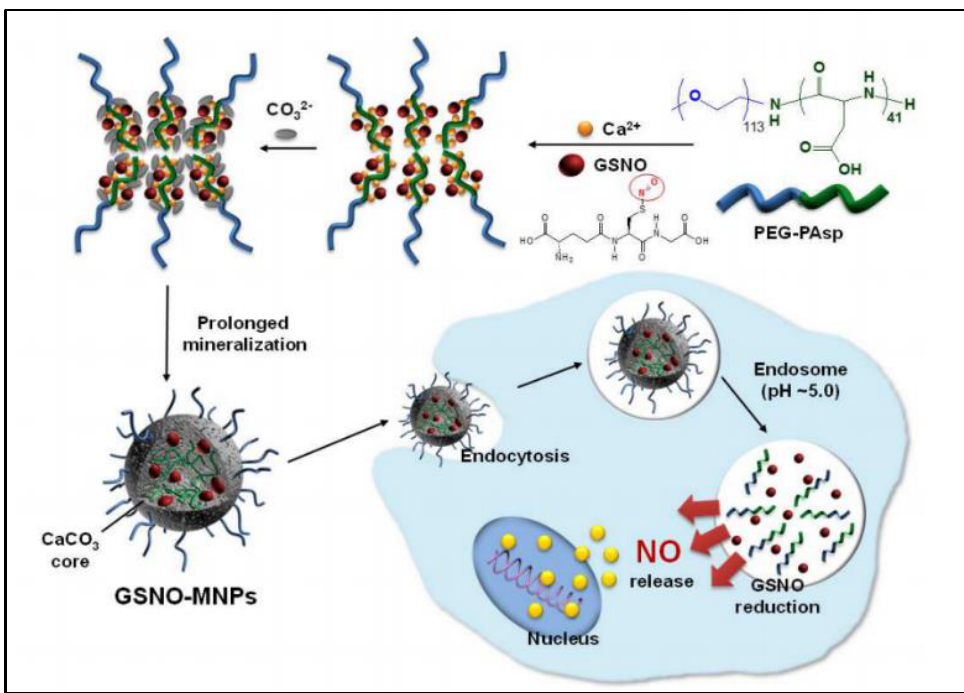
Figure 4. Scheme of preparation of GSNO − loaded CaCO 3 − mineralized nanoparticles [41].